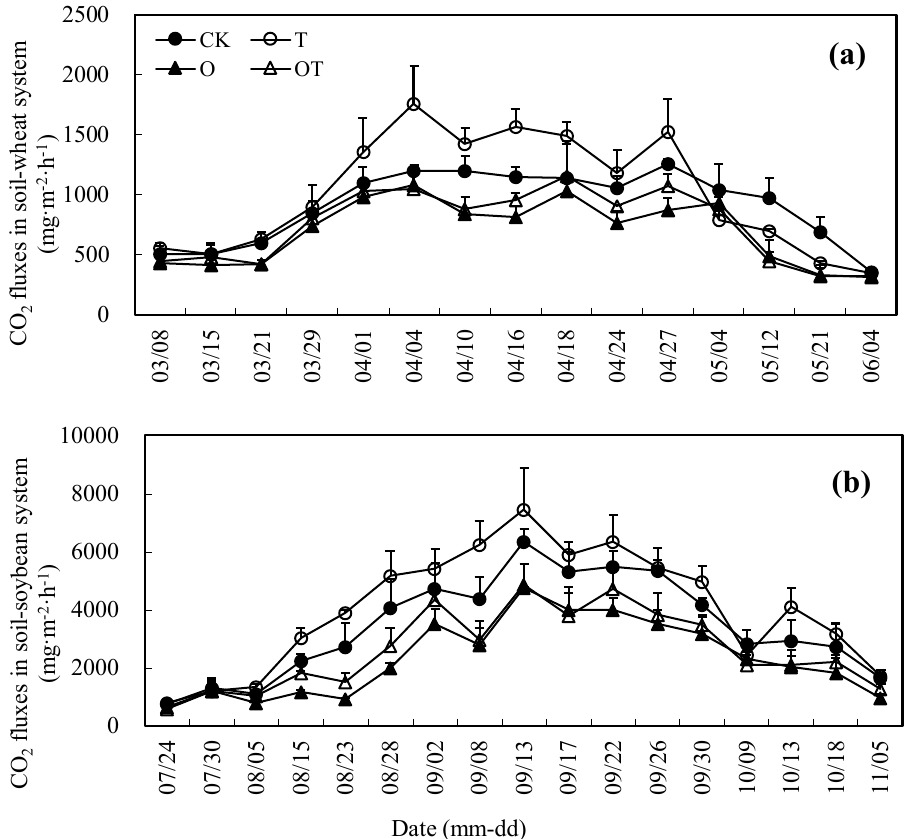
Figure 2. Effect of warming and elevated O 3 concentration on CO 2 emission fluxes from soil-crop system: ( a ) CO 2 emission fluxes from soil-winter wheat system; ( b ) CO 2 emission fluxes from soil-soybean system. Data are the mean values. Error bars are SEs. In figure (a), 03-08 to 03-28 are the turning-green stage, 03-29 to 04-09 are the elongation-booting stage, 04-10 to 04-26 are the heading-flowering stage, and 04-27 to 06-04 are the grain filling-maturity stage. In figure (b), 07-24 to 08-14 are the branching stage, 08-15 to 09-21 are the flowering-pod stage, and 09-22 to 11-05 are the grain filling-maturity stage.